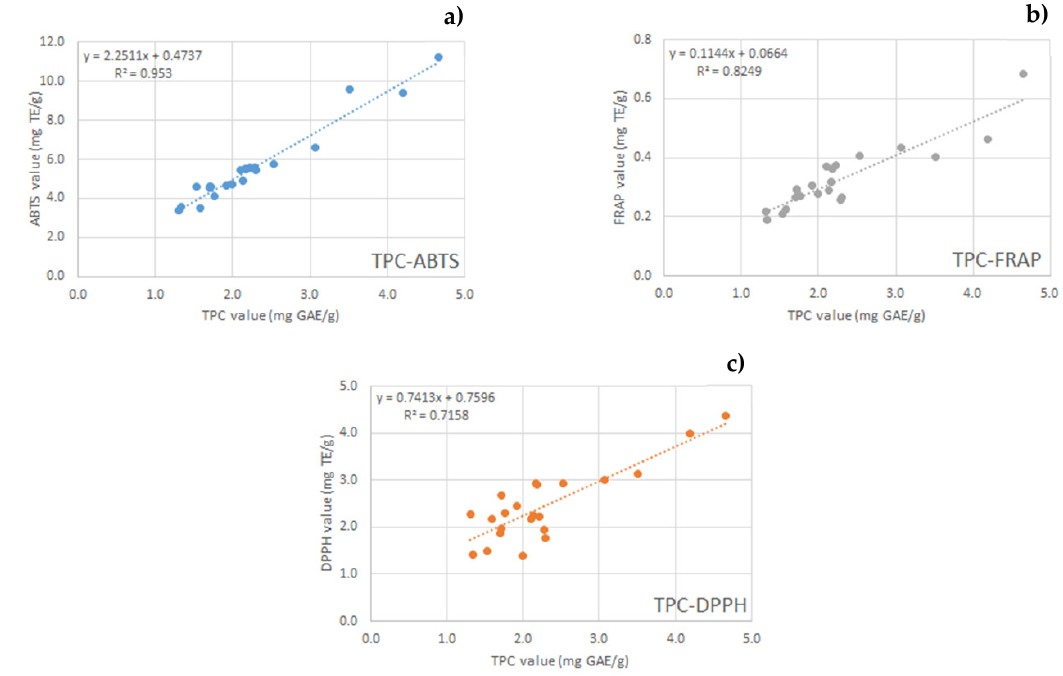
Figure 1. Correlations between TPC and antioxidant activity assays (ABTS, FRAP, DPPH) of all extracts. Correlation between TPC and ABTS ( a ); correlation between TPC and FRAP ( b ); correlation between TPC and DPPH ( c ).